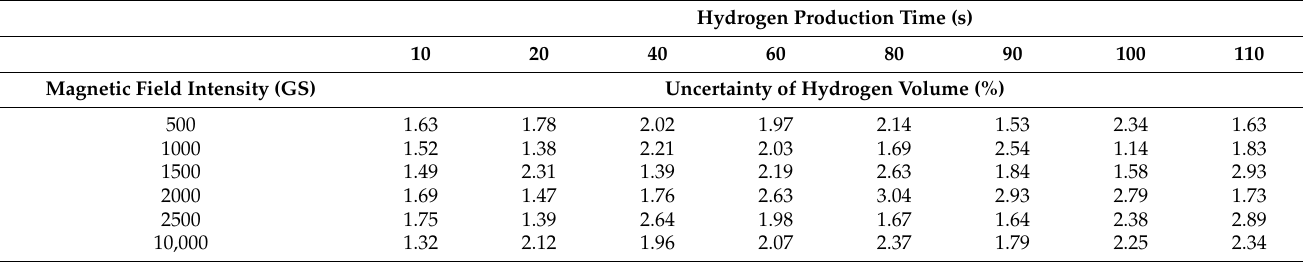
Table 2. The uncertainty of hydrogen production rate in these experiments.